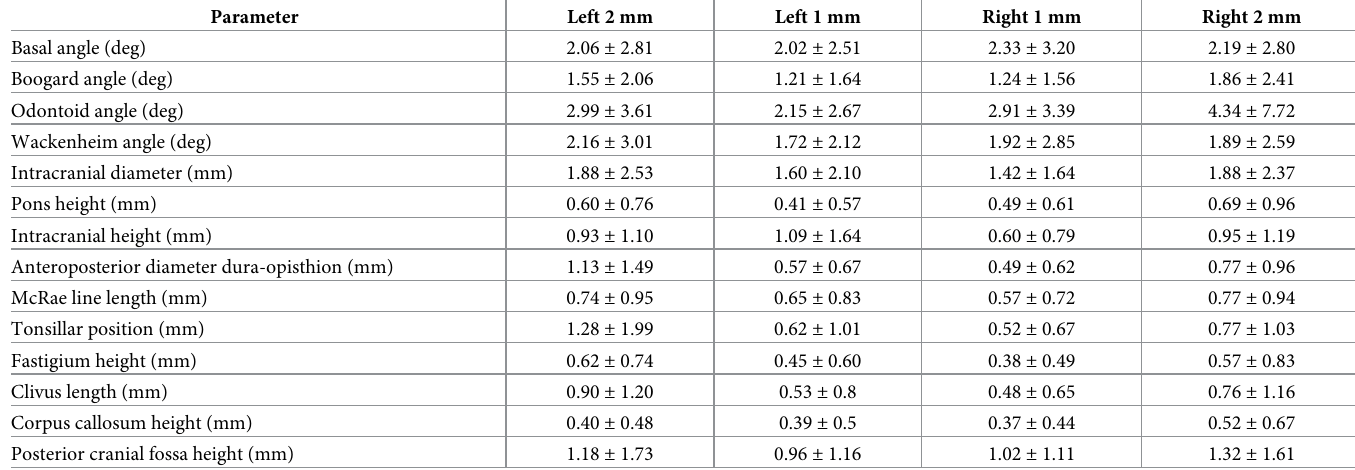
Table 1. Mean individual absolute differences between parasagittal and midsagittal plane measurements (MIAPE) on a given individual (n = 25). Parameter